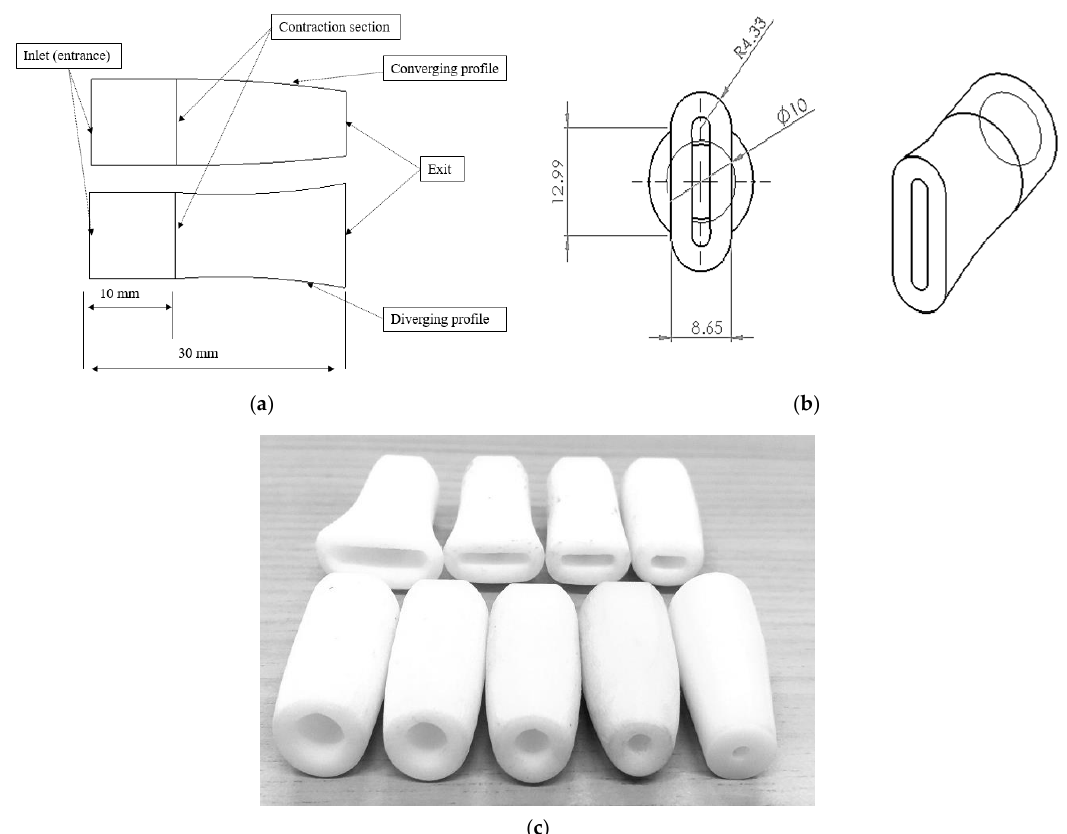
Figure 1. ( a ) Schematic representation of converging or diverging profiles of nozzles, ( b ) manufacturer supplied nozzle (R46) used in dynamic sheet forming and ( c ) 3D printed nozzles used for the present study. Note the following: all the dimensions include the wall thickness of 3 mm.